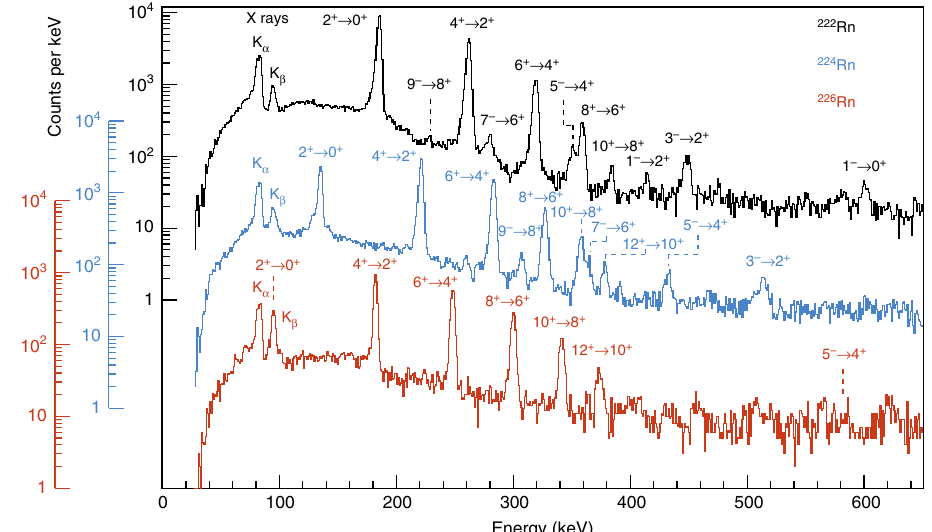
Fig. 1 Spectra of γ -rays. The γ -rays were emitted following the bombardment of 120 Sn targets by 222 Rn (black), 224 Rn (blue) and 226 Rn (red). The γ -rays were corrected for Doppler shift assuming that they are emitted from the scattered projectile. Random coincidences between Miniball and CD detectors have been subtracted. The transitions which give rise to the observed full-energy peaks are labelled by the spin and parity of the initial and fi nal quantum states. The assignments of the transitions from the negative-parity states in 224,226 Rn are tentative (see text)